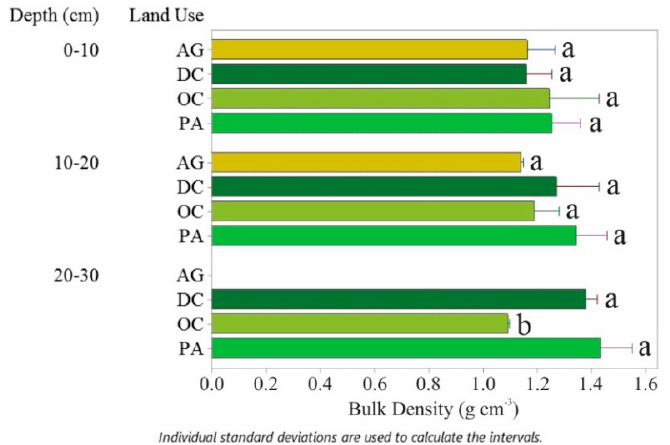
Figure 2. Bulk density by layer under different types of land use in the semi-arid region of Brazil. Note: equal lowercase letters mean no statistical difference between land uses by the Kruskal–Wallis test ( p < 0.05) in the same layers.